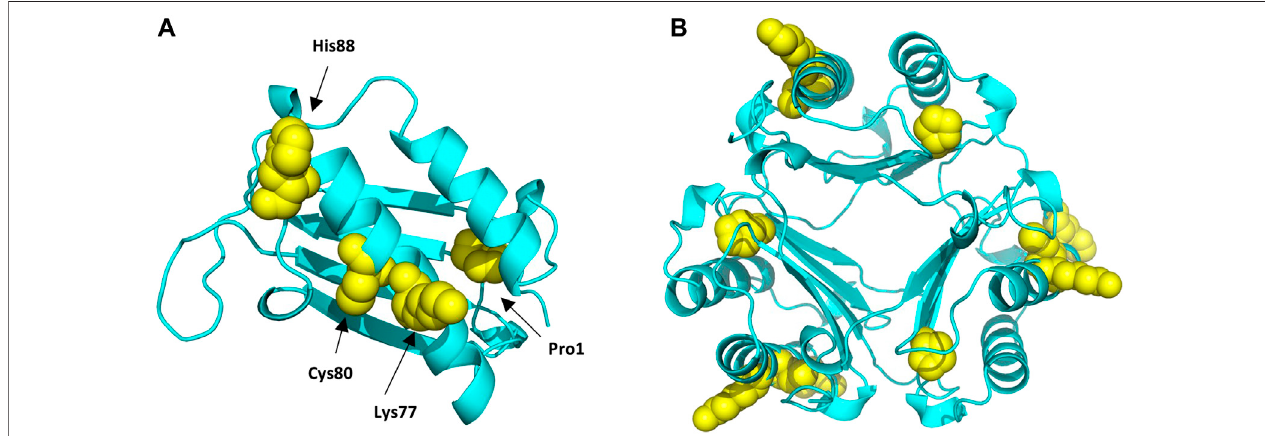
FIGURE 6 | Protein Data Bank (PBD) structure of the MIF monomer (A) , and trimer (B) structure with the different sites modi fi ed by the different haptens tested highlighted in yellow.